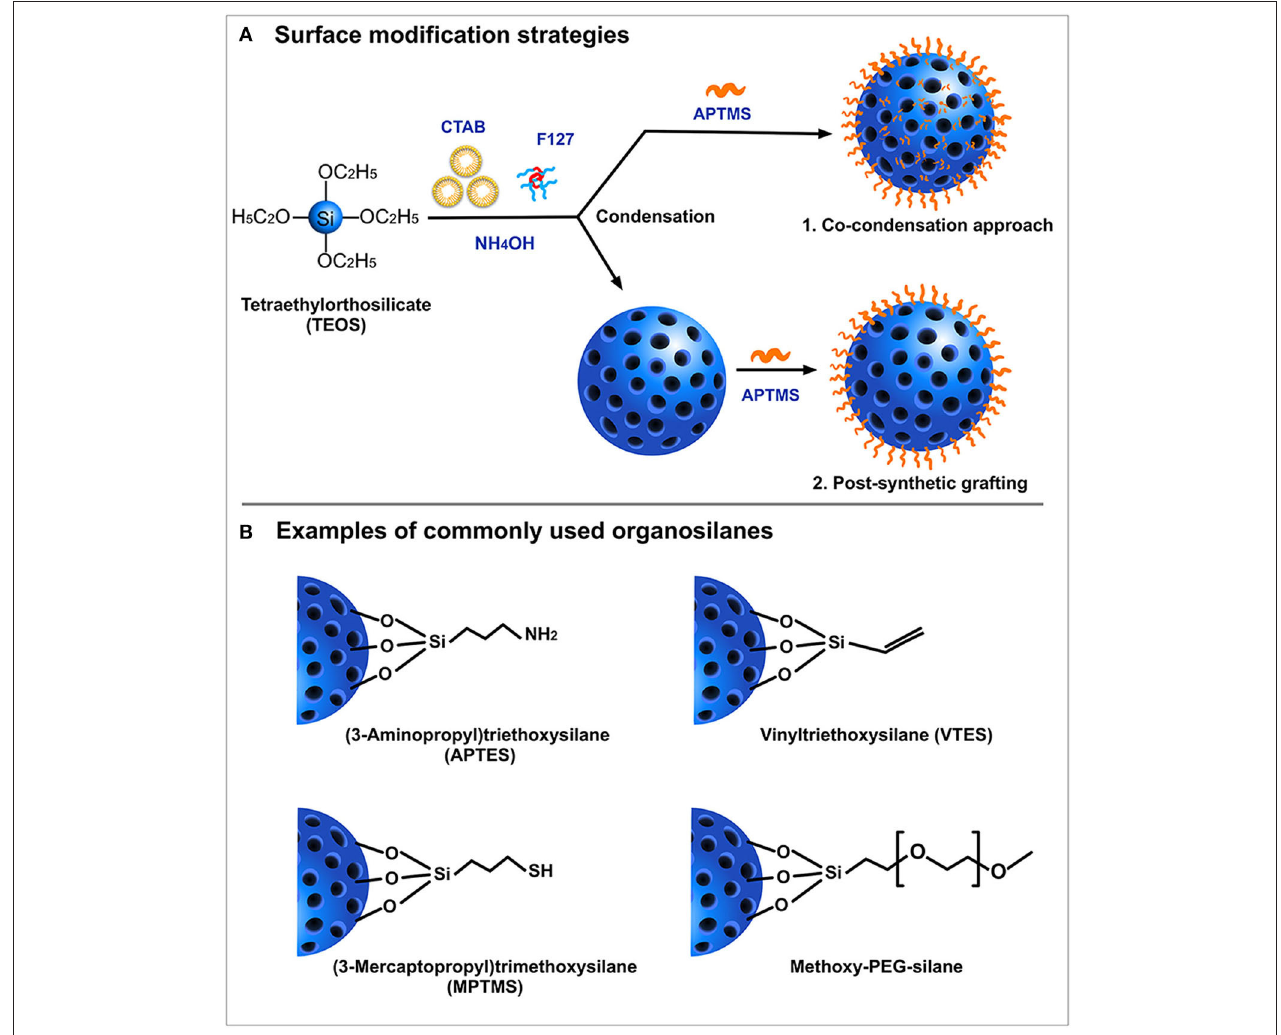
FIGURE 3 | Schematic representation of (A) Surface modification strategies and (B) Examples of most commonly used